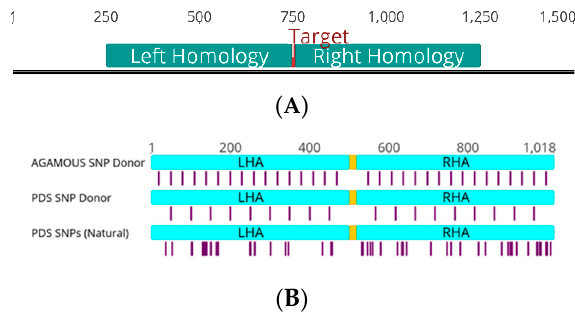
Figure 1. Generalized schema of target sites and donors. ( A ) Generalized genomic site for gene targeting using 500 bp homology arms. Left and Right Homology indicate regions with homology to donor arms. Blue arrows represent the primers that generate the smallest possible amplicon without spurious donor amplification. Target indicates the position of the targeted insertion and nuclease cut site. ( B ) Donor schema for divergent donors. SNP positions indicated by purple bars and yellow bars represent the targeted insertion. The targeted insertion for all donors is at the predicted Cas9 cut site, preventing cleavage of donors and HR repair products. Engineered SNP donors at AGAMOUS and PDS encode SNPs in 30bp and 50bp intervals, respectively. Divergent donors using natural variation between PDS3.1 and PDS3.2 have irregularly spaced SNPs . LHA and RHA indicate left homology arm and right homology arm,